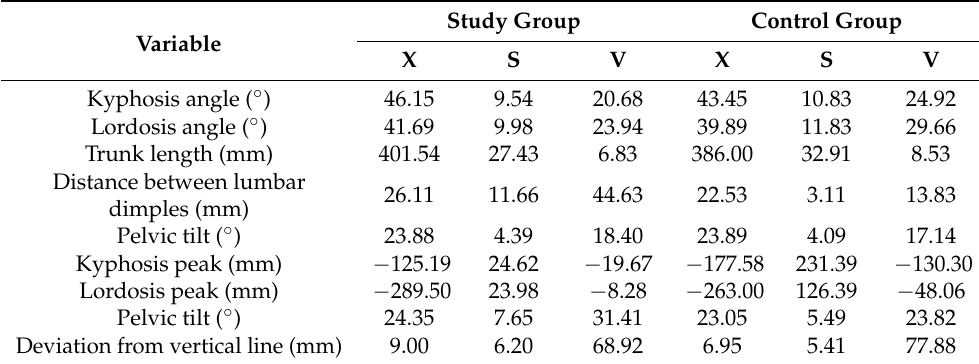
Table 4. Descriptive statistics regarding the examined variable parameters for the sagittal plane in girls from the study and control group. Study Variable